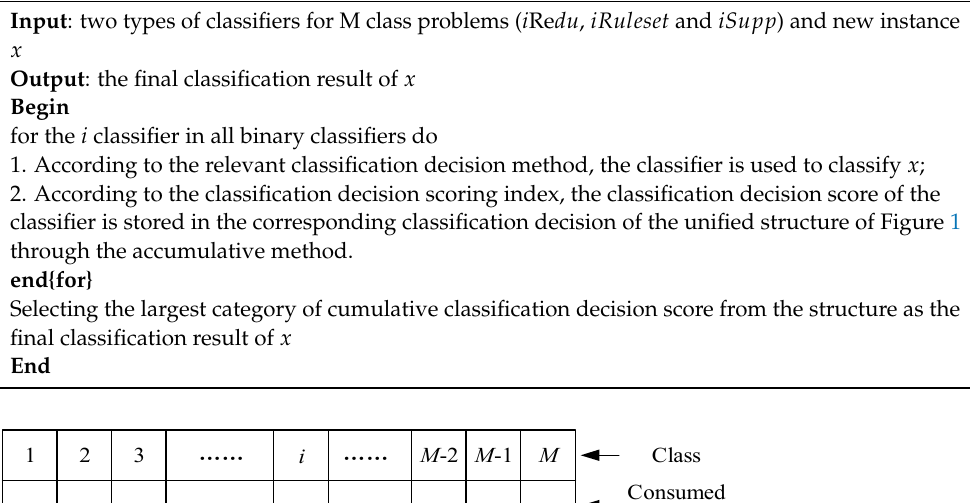
Algorithm 3 Multi-classifier unified collaborative decision algorithm.